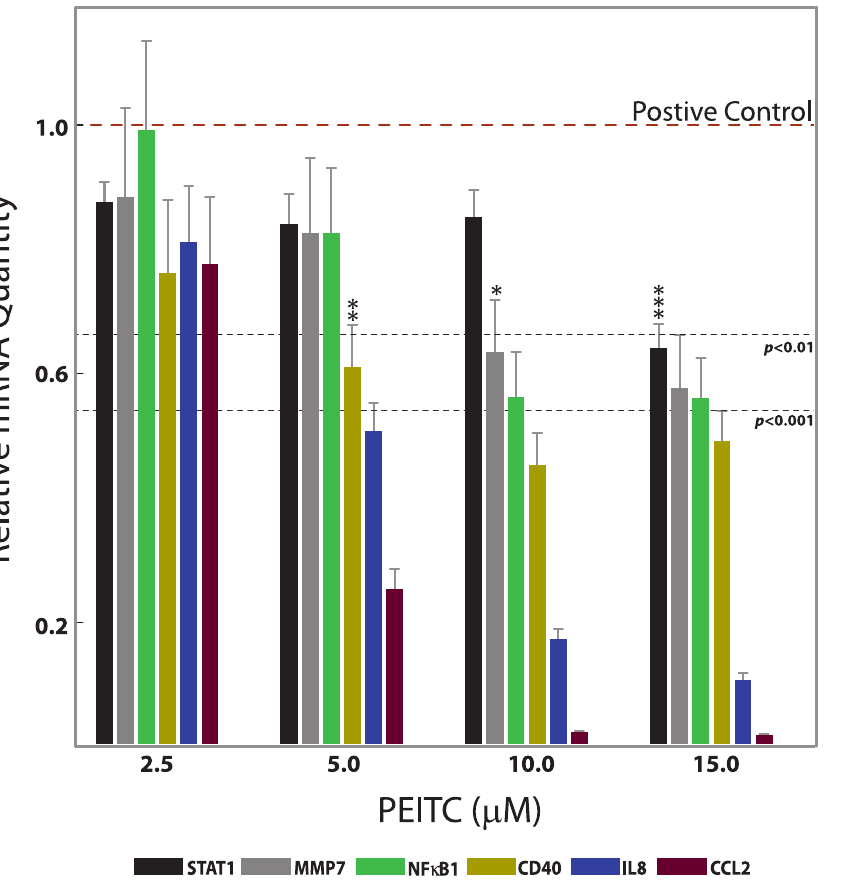
Figure 2. PEITC concentration-dependent mRNA expression of genes of interest (GoI) in SW480 cells at 5 h of PEITC exposure. Six genes are shown for which PEITC-associated changes in H3 modifications were also observed. GoIs for which PEITC-exposure-associated H3 changes were not observed are shown in Table 3, but not in the current figure. The effects of PEITC treatments were measured by the relative mRNA quantity expressed by GoI in the treated cells. The mRNA quantity was measured using real-time RT-PCR, with GAPDH as an internal control. Lower values represent greater inhibitory effects. Values are mean 6 SEM (n=6). *p , 0.05, **p , 0.01, ***p , 0.001. When all values below the dotted line correspond to the same category of p value, individual stars are omitted to avoid overcrowding of the figure. Statistical significances were measured relative to the positive control, which are cells treated with LPS and no PEITC, showing the highest gene induction levels.